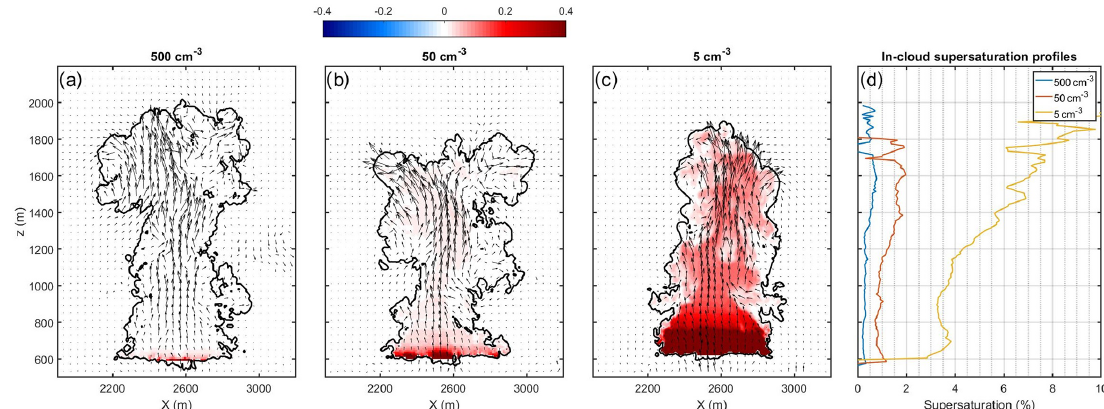
Figure 5. Microphysical effects on AF. The droplet concentration (i.e., aerosols) affects AF through the profile of supersaturation inside the cloud. Panels (a) – (c) present cross sections of AF s (with the supersaturation term) minus AF ref . (a) For high N a of 500cm − 3 (as in Fig. 3d). (b) For 50cm − 3 at 33min. (c) For 5cm − 3 at 31min. (d) In-cloud supersaturation profiles.